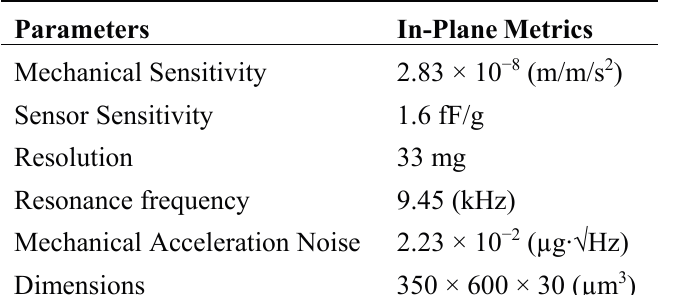
Table 1. Accelerometer specifications.